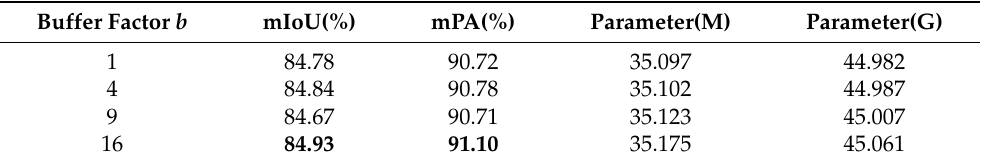
Table 4. It is important to set the appropriate buffer factor in Channel Ladder Refinement (CLR) (bold represents the best result).